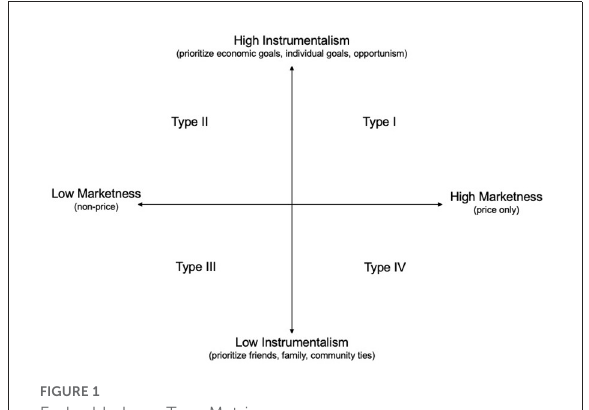
FIGURE1 Embeddedness Type